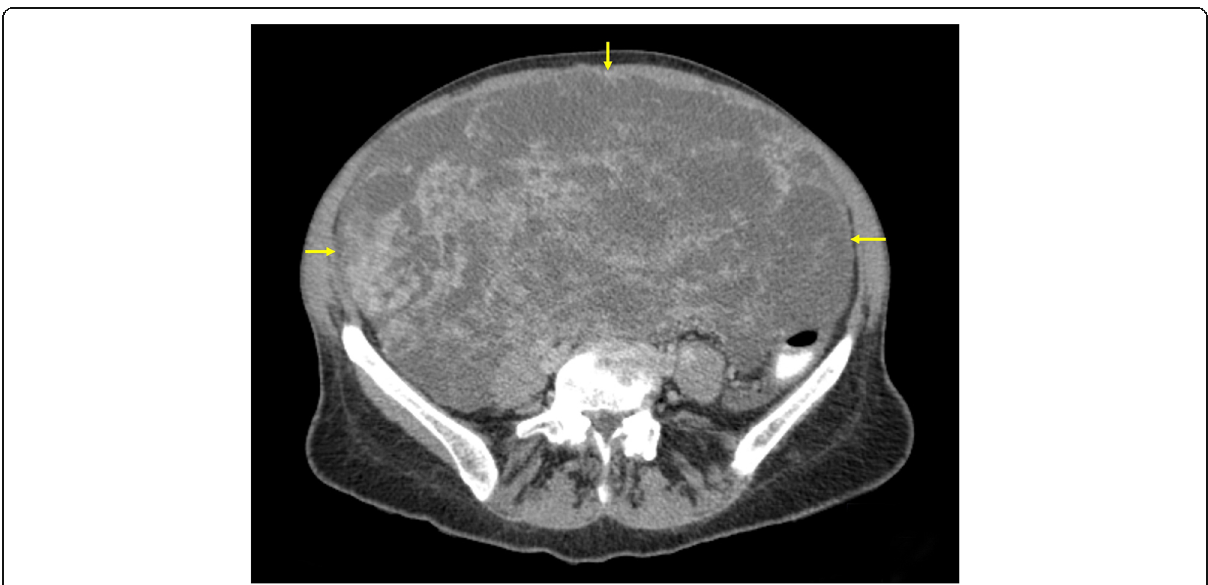
Fig. 4 Axial post-contrast MDCT image at the level of the iliac crests. The heterogeneous tumour (yellow arrows) is more representative at this level and occupies the whole peritoneal cavity